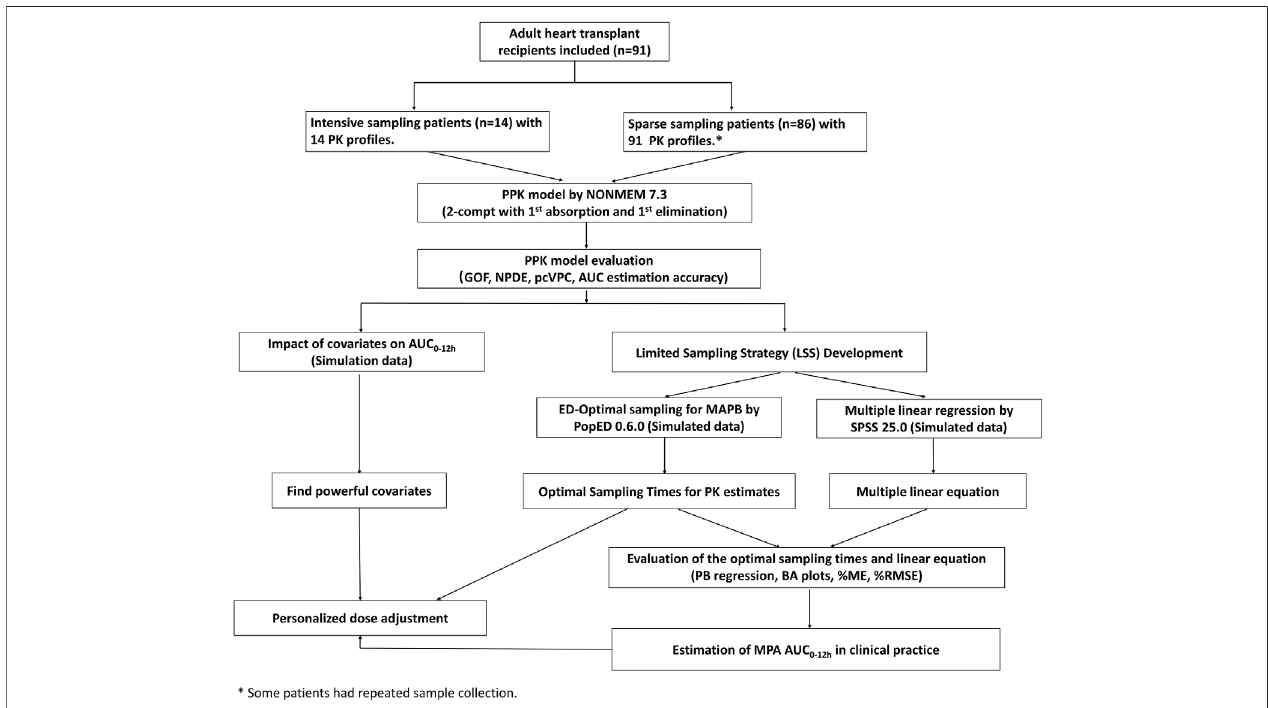
FIGURE 1 | Flowchart of the study. PPK, population pharmacokinetic; AUC 0 – 12h , the area under the curve of the dosing interval; MPA, mycophenolic acid; GOF, goodness-of- fi t; NPDE, normalized prediction distribution error; pcVPC, prediction-corrected visual predictive check; MAPB, maximum a posteriori Bayesian; PB regression, Passing – Bablok regression; BA plot, Bland-Altman plot; %ME, mean error in percentage; and %RMSE, percent root mean squared